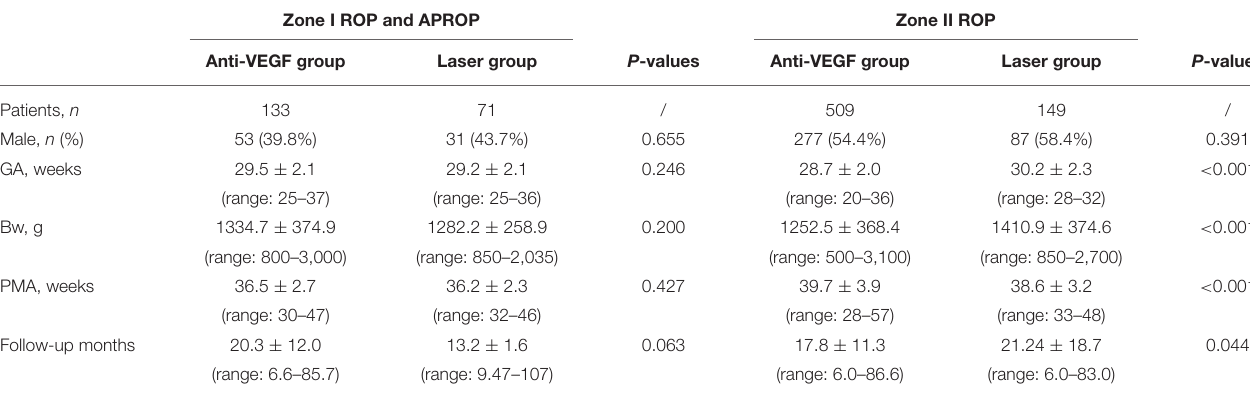
TABLE 1 | Demographics of the infants